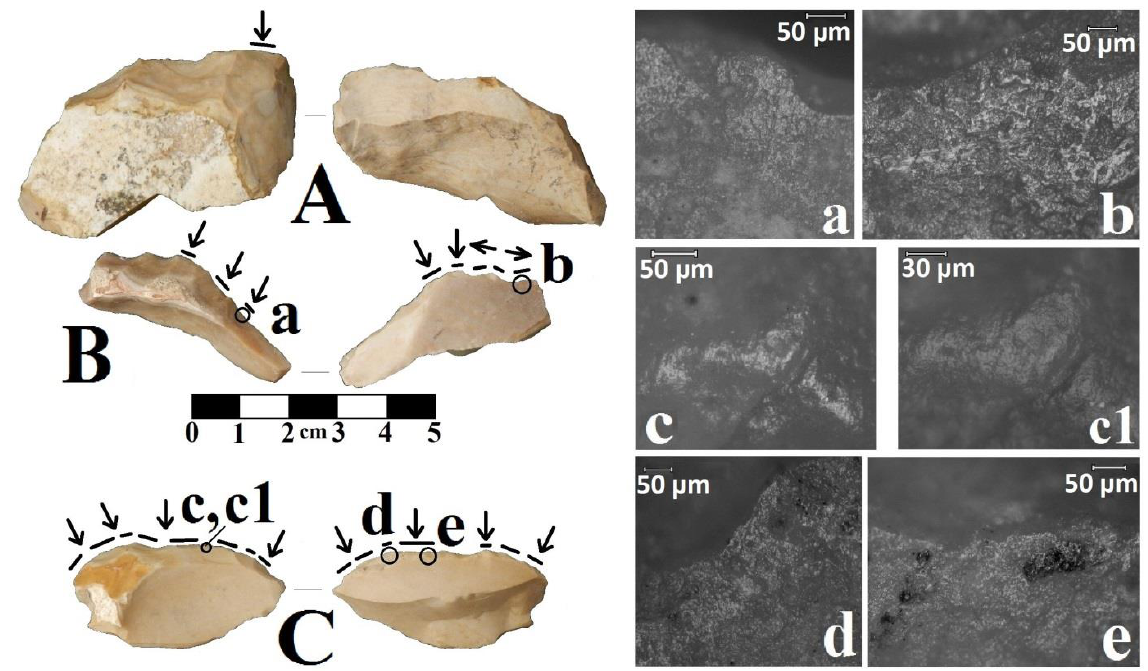
Figure 3. Three spalls ( A, B, C ) removed from fan scrapers used to skin and butcher animals. a, d, e : edge- rounding and rough “greasy” hide or meat polish (black spots on d and e ). c and c1 : Heavy edge-rounding and microwear from dry hide. Microwear on A weakly-developed. All photomicrographs except c1 are at 187.5x, with scales that are 50 microns. The scale on c1 is 30 microns, and magnification is 375x. A : Thick convex- edged spall of banded flint (MW#4) Area D, Early Bronze Age (EBA) layer, Locus 2041, Bucket 20195. B : Lustrous convex fan scraper spall (MW#5) with patina, Area E, late Pottery Neolithic (PN) layer, Locus 3135, Bucket 30816. C : Lustrous straight-edged fan scraper spall (MW#6) with patina, Area E, late PN layer, Locus 3158, Bucket 30857. Table 3. Ein Zippori fan scrapers: edge-angles and tool motion. Abbreviations: N - number, Both - both cutting and